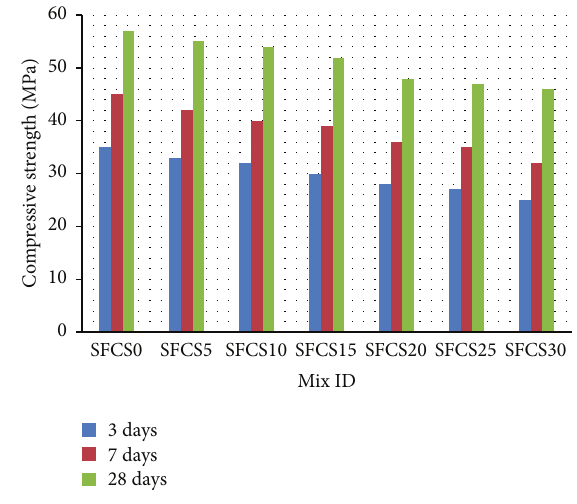
Figure 1: Compressive strength of mortar